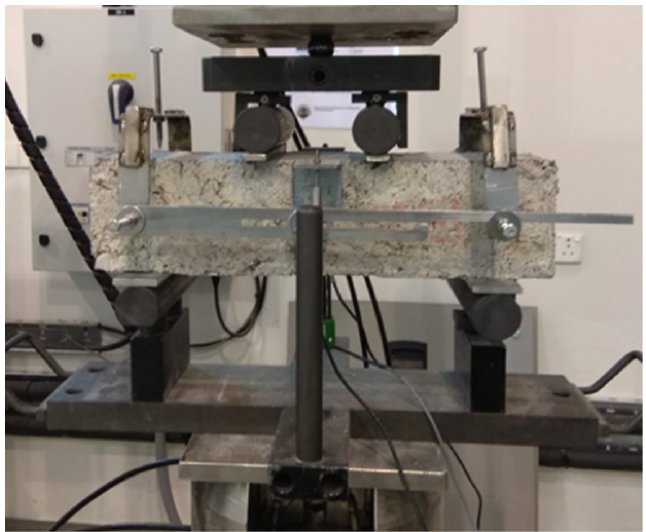
Figure 1. Four-point bending test setup.